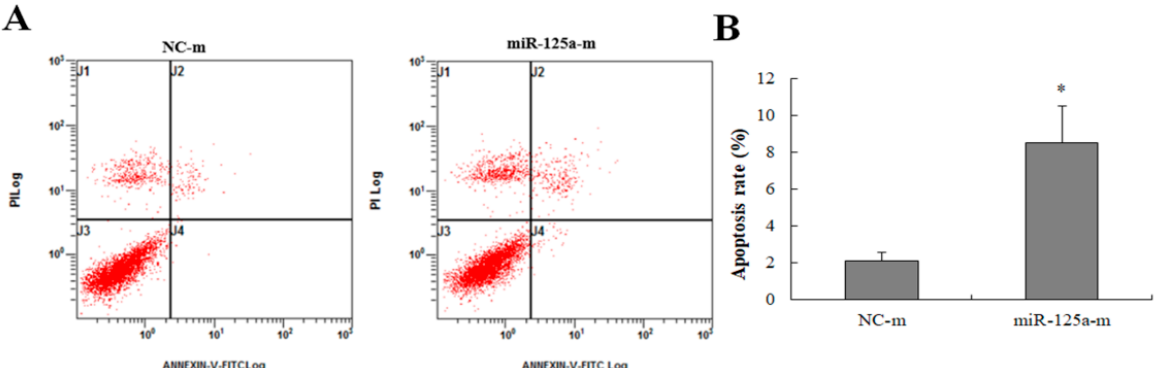
Figure 3. The effect of miR ‐ 125a on hepatocytes apoptosis. ( A ) .The apoptotic rate was examined through FACScan the after treatment of miR ‐ 125a mimics and NC mimics, respectively. J4 (the number of early apoptosis cells) as well as J2 (the number of late apoptosis cells) areas are represented as apoptotic cells. ( B ) . Apoptosis rate is represented by a histogram. Data are shown as mean ± SEM, * p < 0.05.